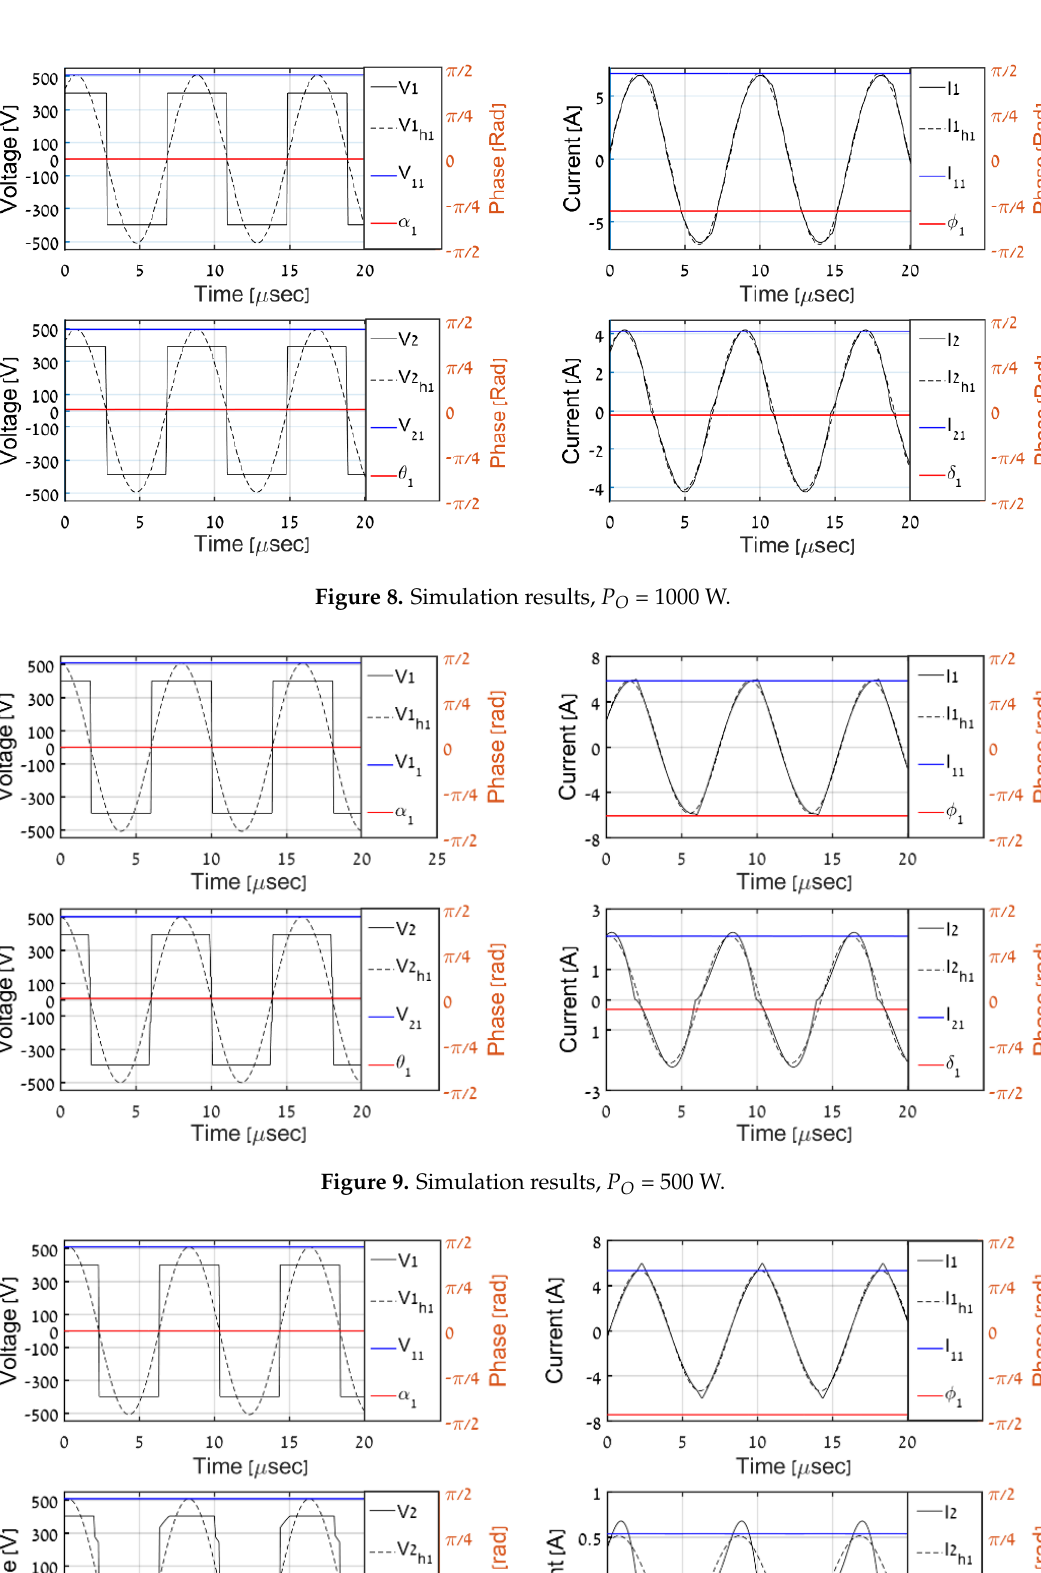
Figure 10. Simulation results, P O = 200 W.